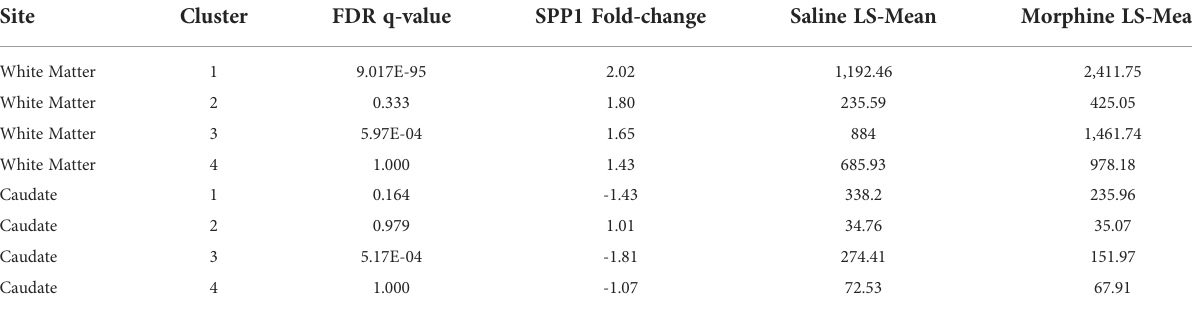
TABLE 4 Morphine effect on SPP1 expression in microglia nuclei from the white matter and